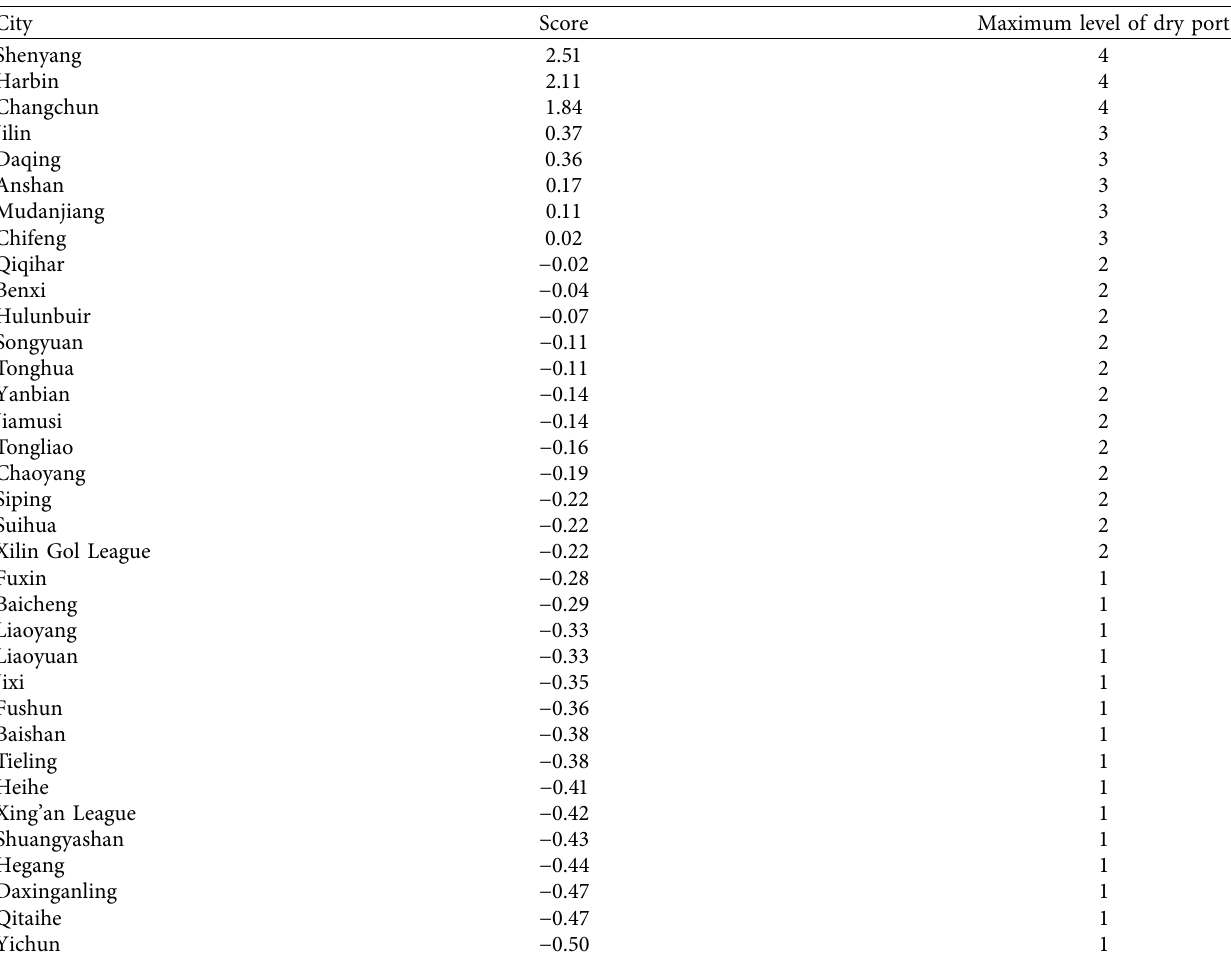
Table 8: Score and grade limit of dry port construction capacity of each city.